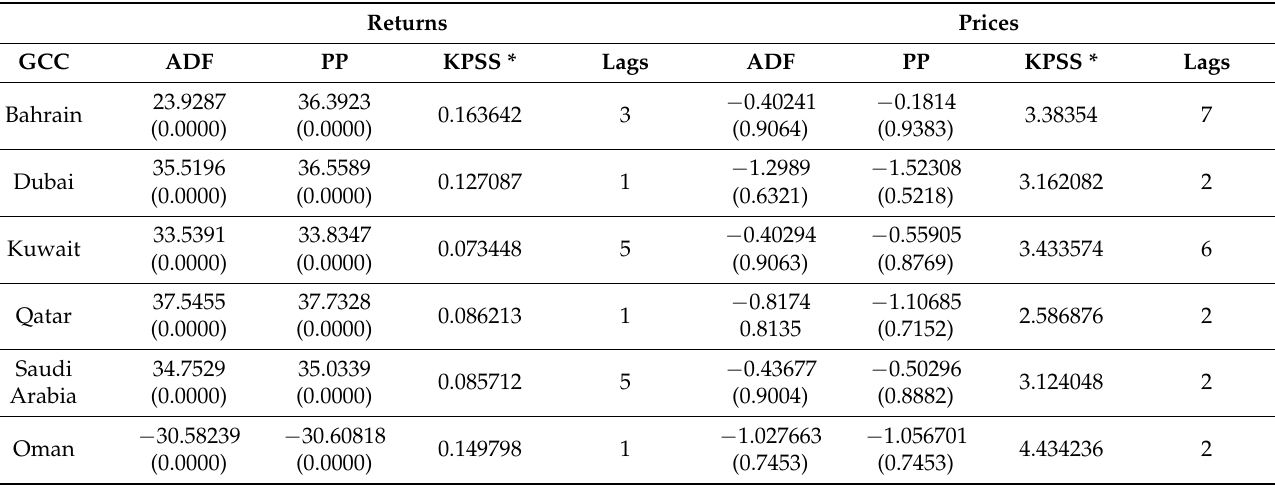
Table 7. GCC Unit Root test.